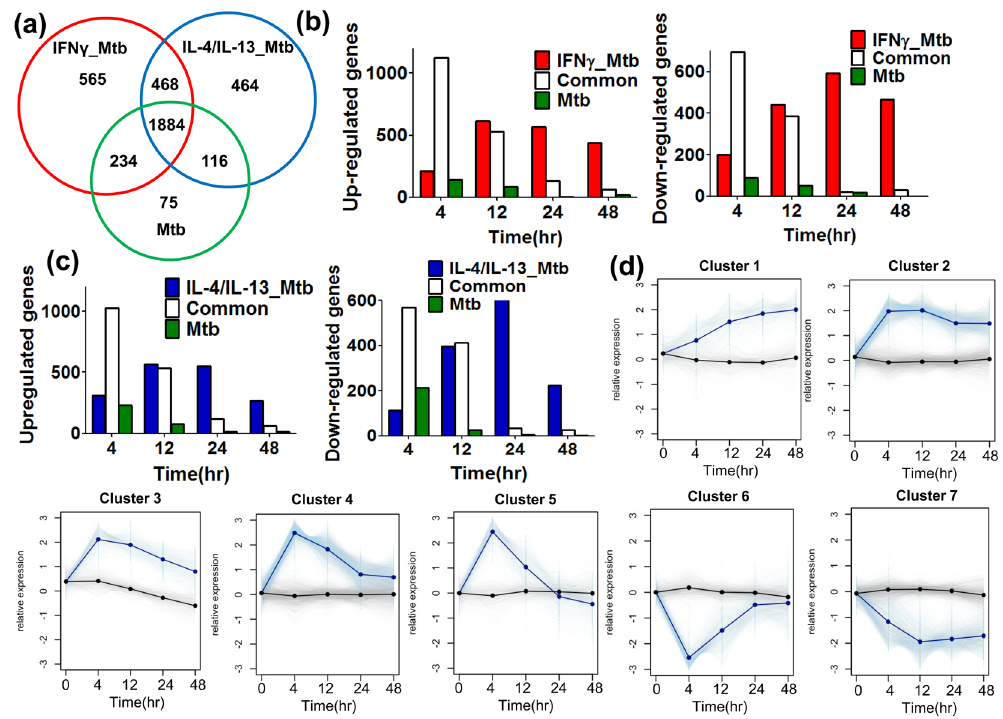
Figure 3. Effect of IFN γ and IL-4/IL-13 pre-stimulation in Mtb-infected macrophages. ( a ) Venn diagram analysis of differentially expressed genes in Mtb, IFN γ _Mtb and IL-4/IL-13_Mtb. The overall landscape of differentially expressed (up and down) genes regardless of time was shown. There are same gene up and down regulated at different time point for the same condition (11 in IFN γ _Mtb and 3 in IL-4/IL-13_Mtb) which were excluded from the venn diagram analysis. ( b ) Number of up-regulated (left panel) and down-regulated (right panel) genes at each time point in Mtb and IFN γ _Mtb. Open column indicates commonly regulated genes and red and green column indicate specifically regulated genes in IFN γ _Mtb and Mtb, respectively. ( c ) Number of up-regulated (left panel) and down-regulated (right panel) genes at each time point in Mtb and IL-4/IL-13_Mtb. Open column indicates commonly regulated genes and blue and green column indicate specifically regulated genes inIL-4/IL-13_Mtb and Mtb, respectively. ( d ) Seven clusters of the k -means clustering analysis for differentially expressed genes in Mtb infection are shown. We visualized the time-dependent pattern of expression change by plotting the expression of the genes that were centers of each cluster (thick black line for control and thick blue line for the condition). The remaining genes were plotted in fine lines, grey for control and light blue for the condition. The control is the mean expression of all replicates of unstimulated non- infected BMDM at each time points. Thus the controls average/center around zero (the average fold change of controls vs mean control is